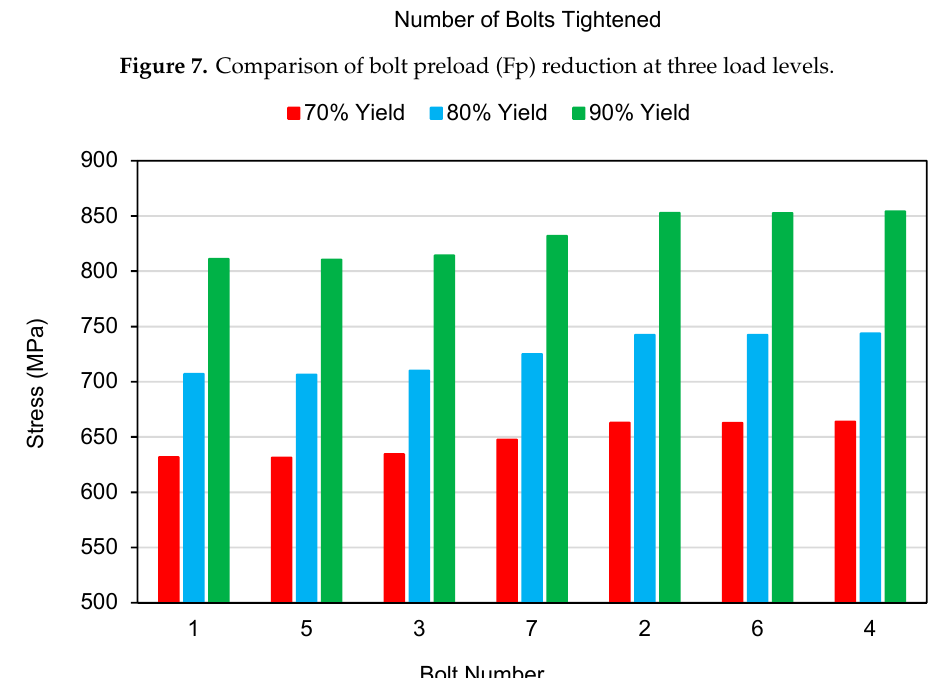
Figure 8. Fp scatter in di ff erent bolts at various load levels .